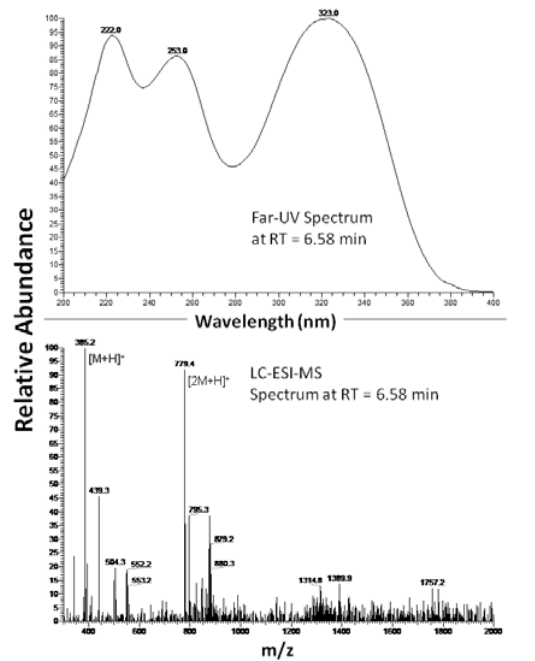
Figure 1. Far-UV spectrum and spectrum